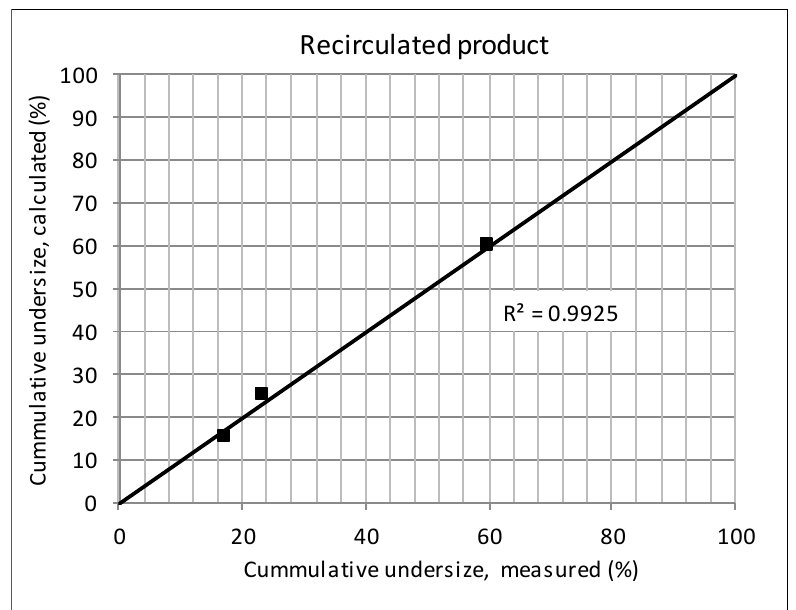
Figure 6. Zero error graph, recirculated product fitted to the SWEF model.